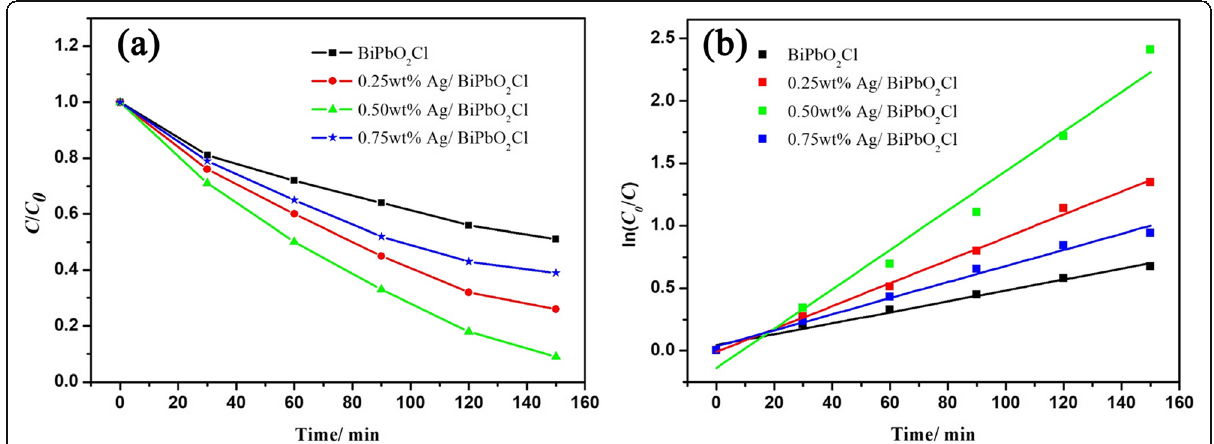
Fig. 1 a Photocatalytic degradation of MO with BiPbO 2 Cl and Ag/BiPbO 2 Cl composites. b Kinetics of MO decolorization in